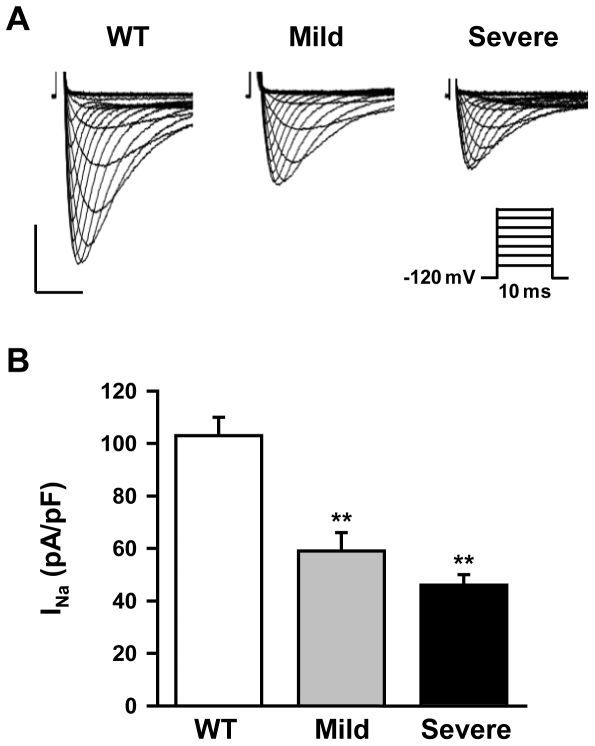
Variable INa densities in Scn5a
+/− single ventricular cardiomyocytes.
A. Representative INa traces (protocol in inset) obtained from ventricular myocytes in a 12 week-old WT mouse and Scn5a
+/− mice with mild and severe phenotype. Horizontal bar, 2 ms; vertical bar, 40 pA/pF. B. INa density in myocytes from WT and Scn5a
+/− mice with mild and severe phenotype (4 mice in each group, 4 to 6 cells for each mouse). **, p<0.01 versus WT mice.